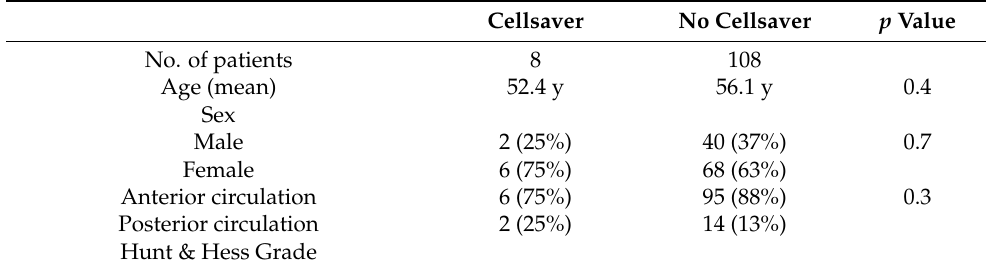
Table 2. Data of patients in the ruptured group stratified by RBC retransfusion and no